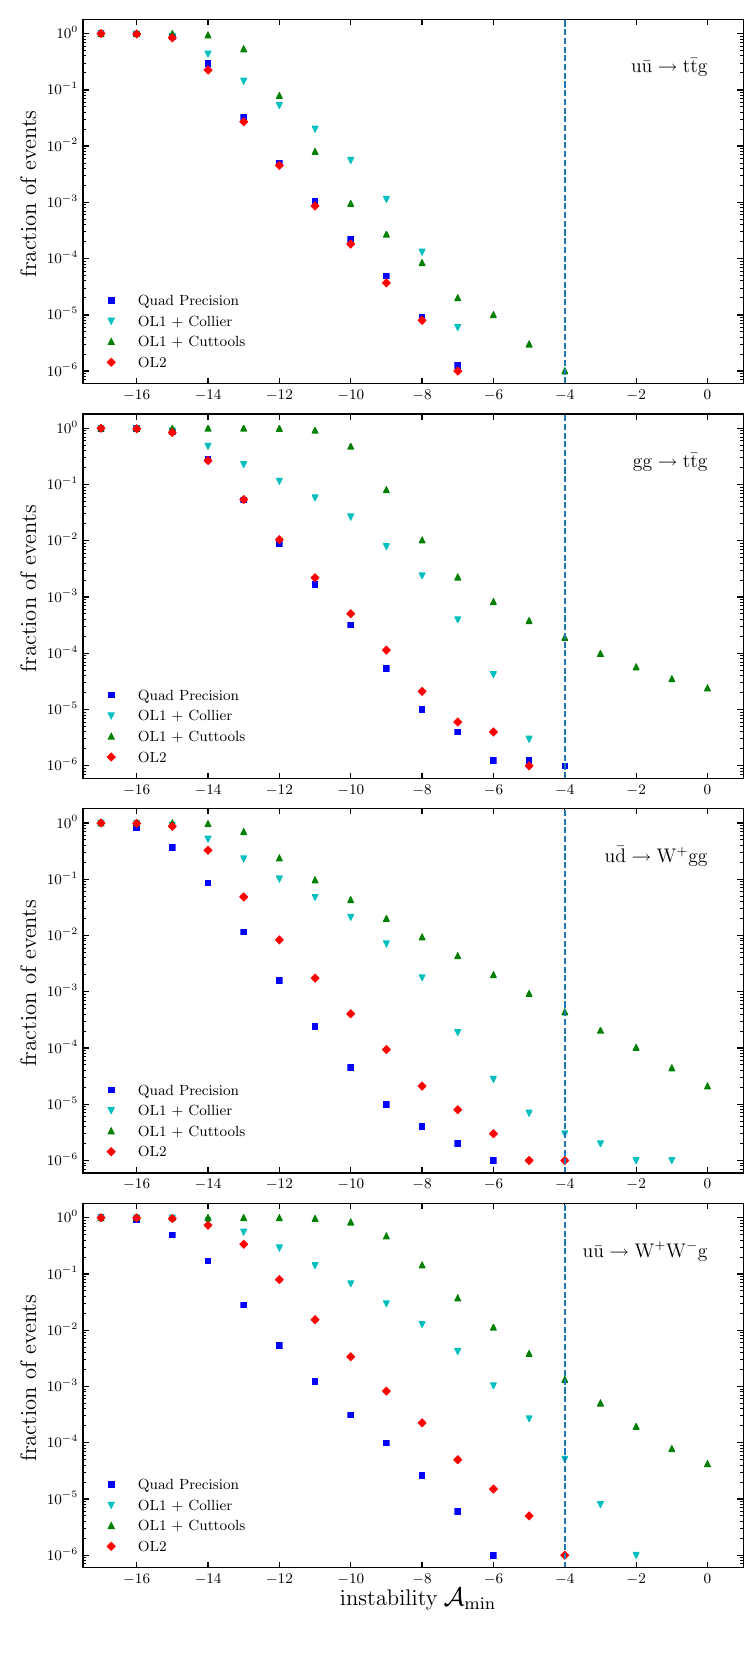
Fig. 16 Stability distributions for 2 → 3 processes defined as in Fig. 14. The stability of OpenLoops2 with on-the-fly reduction is compared to OpenLoops1 with Collier or Cuttools . The instability